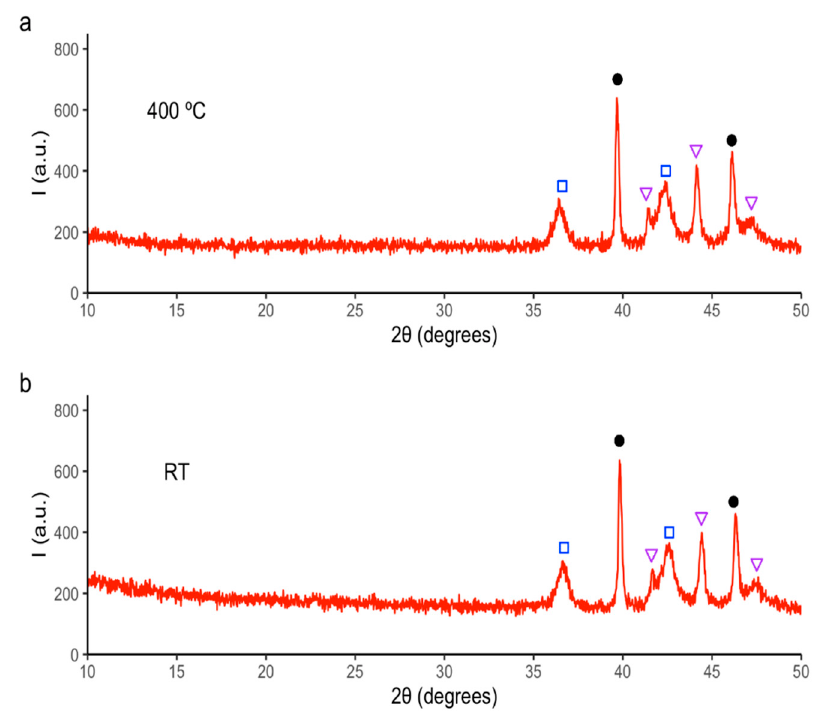
Figure 8. X-ray powder diffraction of cobalt acetate tetrahydrate heated under N 2 atmosphere at 400 ◦ C ( a ) and quenched back to 25 ◦ C ( b ). Main peaks of identified phases are marked as follows: black circle for platinum (PDF-01-087-0642), blue square for CoO rocksalt polymorph (PDF 00-048-1719), purple inverted triangle for Co (PDF-01-089-4308), and orange crossed circles for Co 3 O 4 (PDF-01- 086-8289).